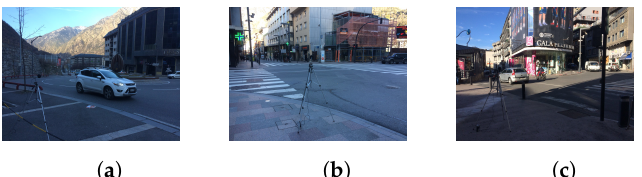
equipment was placed in order to achieve reliable data. ( a ) Ctra.de l’Obac, 19; ( b ) Av.Carlemany, 121; ( c ) Av. Meritxell,